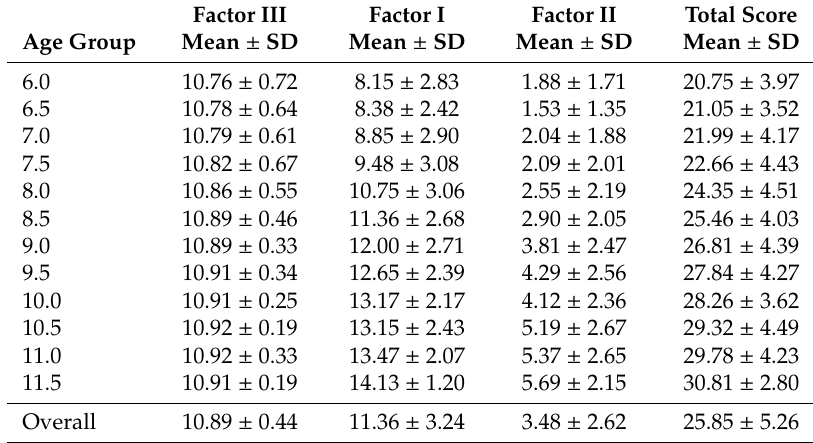
Table 3. Mean and standard deviation of RCPM scores, according to the three-factorial clustering in each age